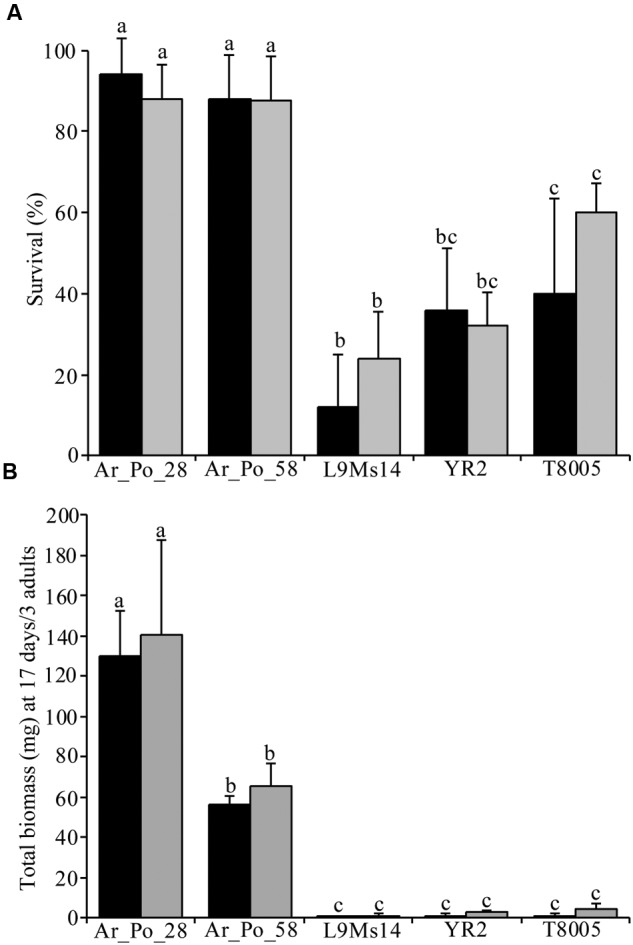
ZP1109 and ZP1130 allow only A. pisum pea biotype reproduction. Survival (A) and biomass (B) of five aphid lineages are measured on the pea cultivars ZP1109 (black bars) and ZP1130 (gray bars). Bars show the average of survival or biomass and standard deviation for five replicates per conditions. Statistical differences between groups are indicated by different letters. a, b, c; indicate groups determined by multiple comparisons tests after GLM and ANOVA analyses for survival and biomass data, respectively.